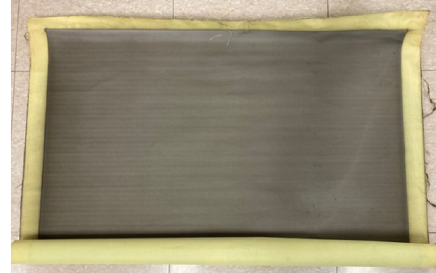
Figure 11. Finished tungsten-coated shielding fabric.